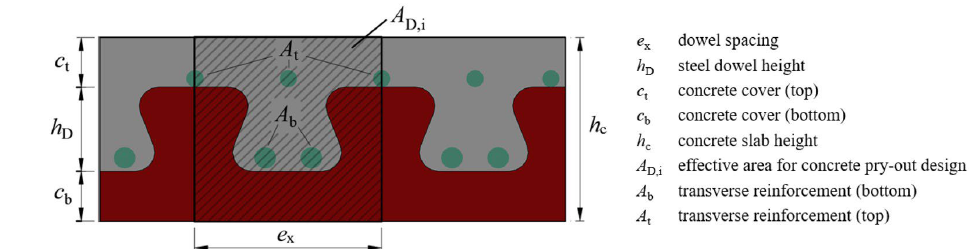
Figure 4. Parameters of composite